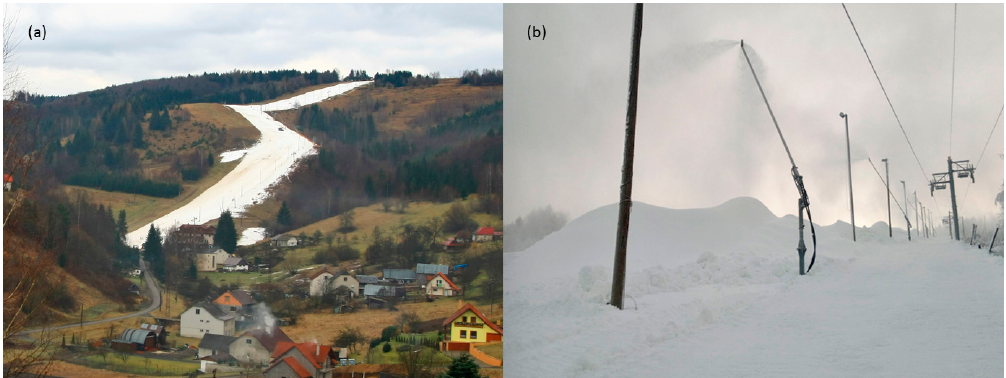
Figure 1. ( a ) The studied ski slope of the Košútka Ski Centre after the snowmelt of natural snow in the surroundings of the ski slope on 18 February 2016; ( b ) The beginning of the season started with an enormous production of snow (base layer snowmaking; 21 December 2016). Shown are snowmaking lances beside the ski lift at the orographic left side of the slope.